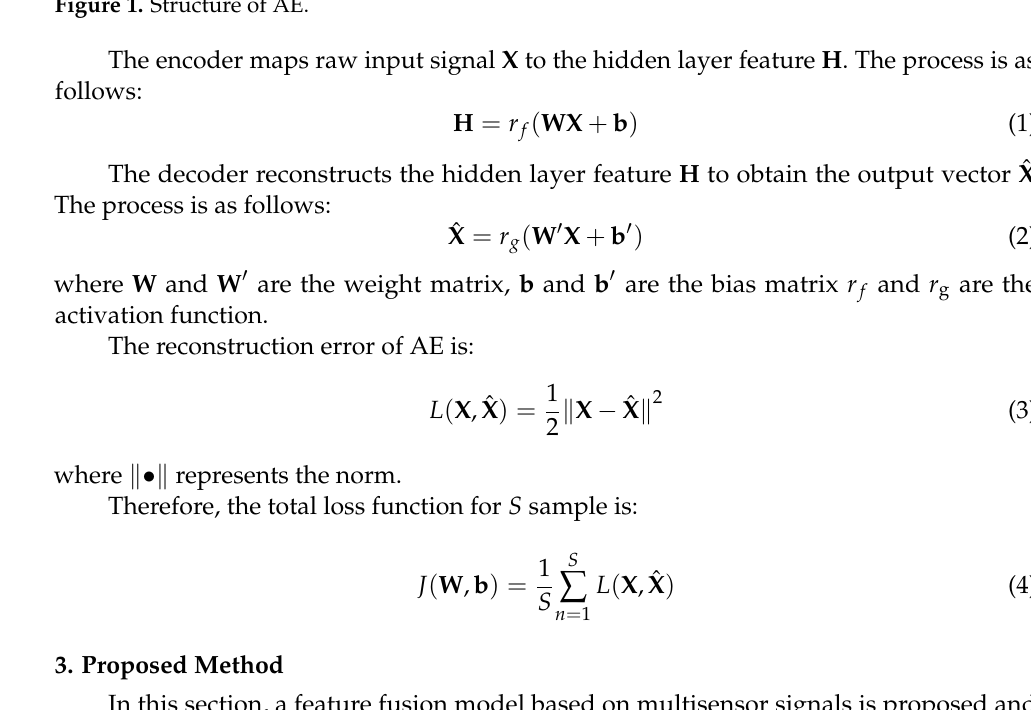
Figure 1. Structure of AE.